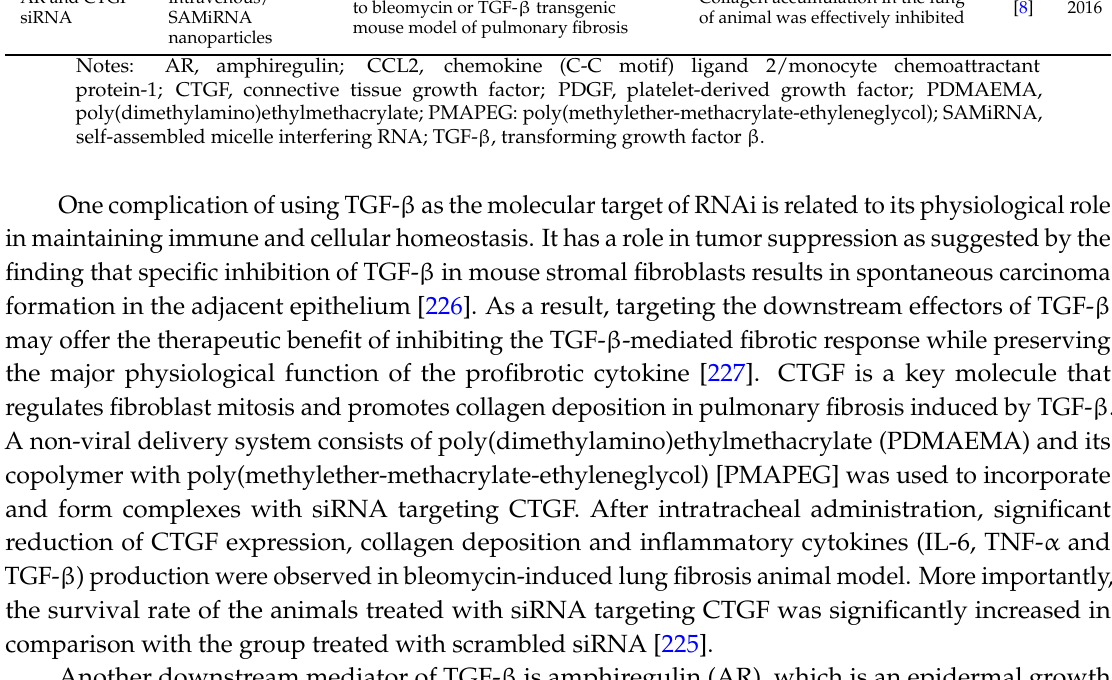
Key Observations